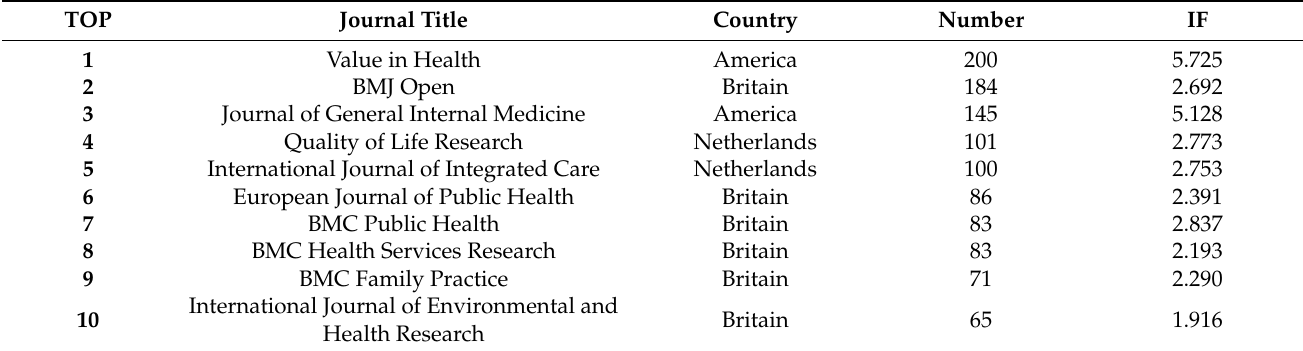
Table 1. Top 10 English Journals